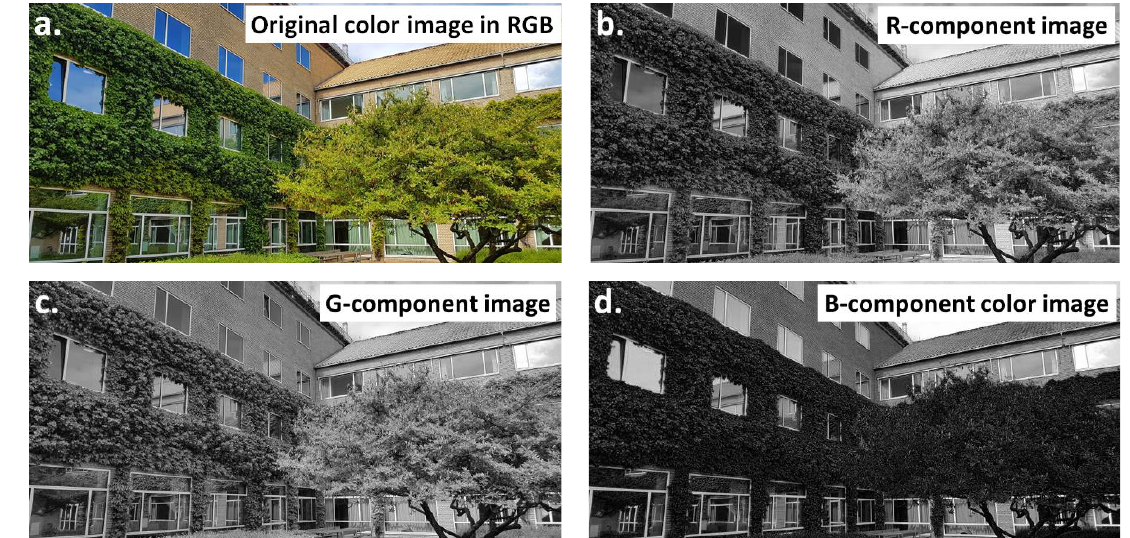
Figure 3. Comparison of ( a ) the color image in the RGB model, and images formed by decomposing the image into ( b ) R, ( c ) G, ( d ) B components.